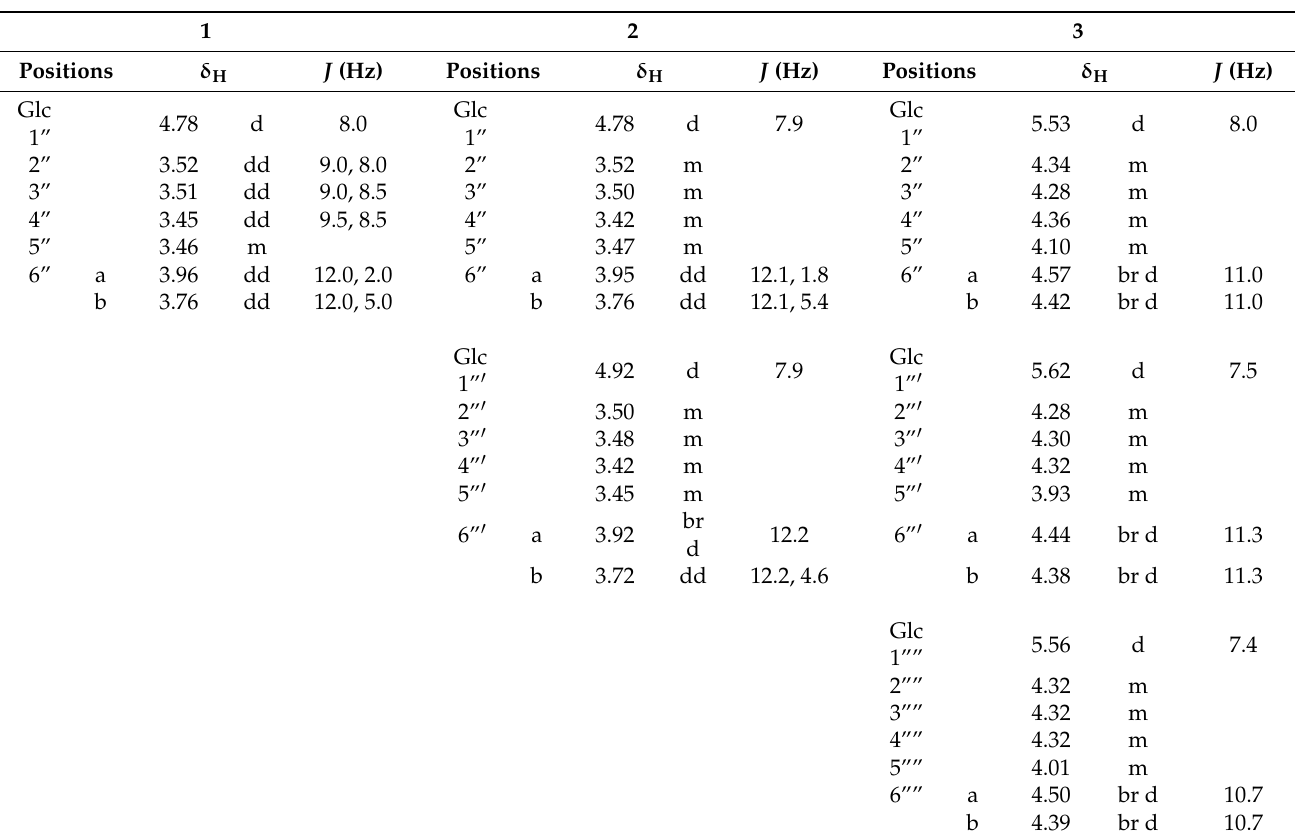
Table 2. 1 H-NMR spectral data for the sugar moieties of 1 – 3